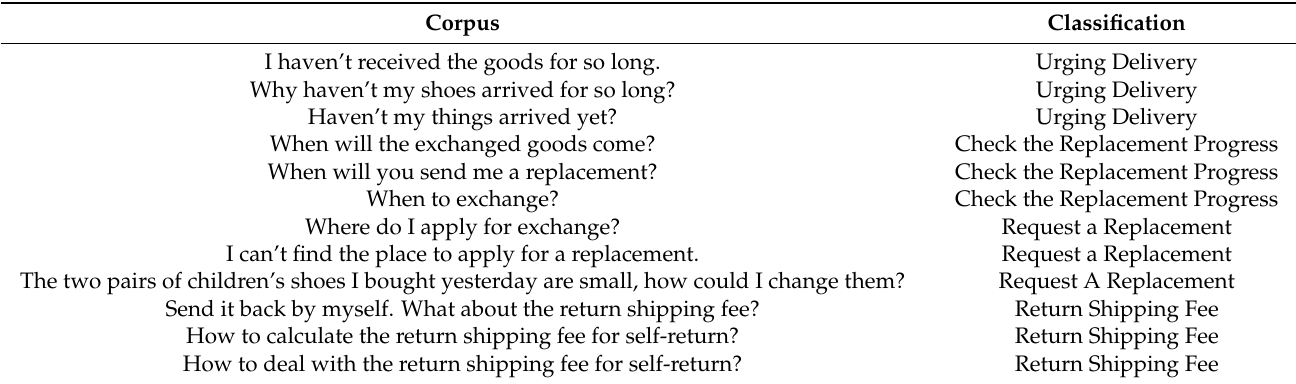
Table 1. Part of the training